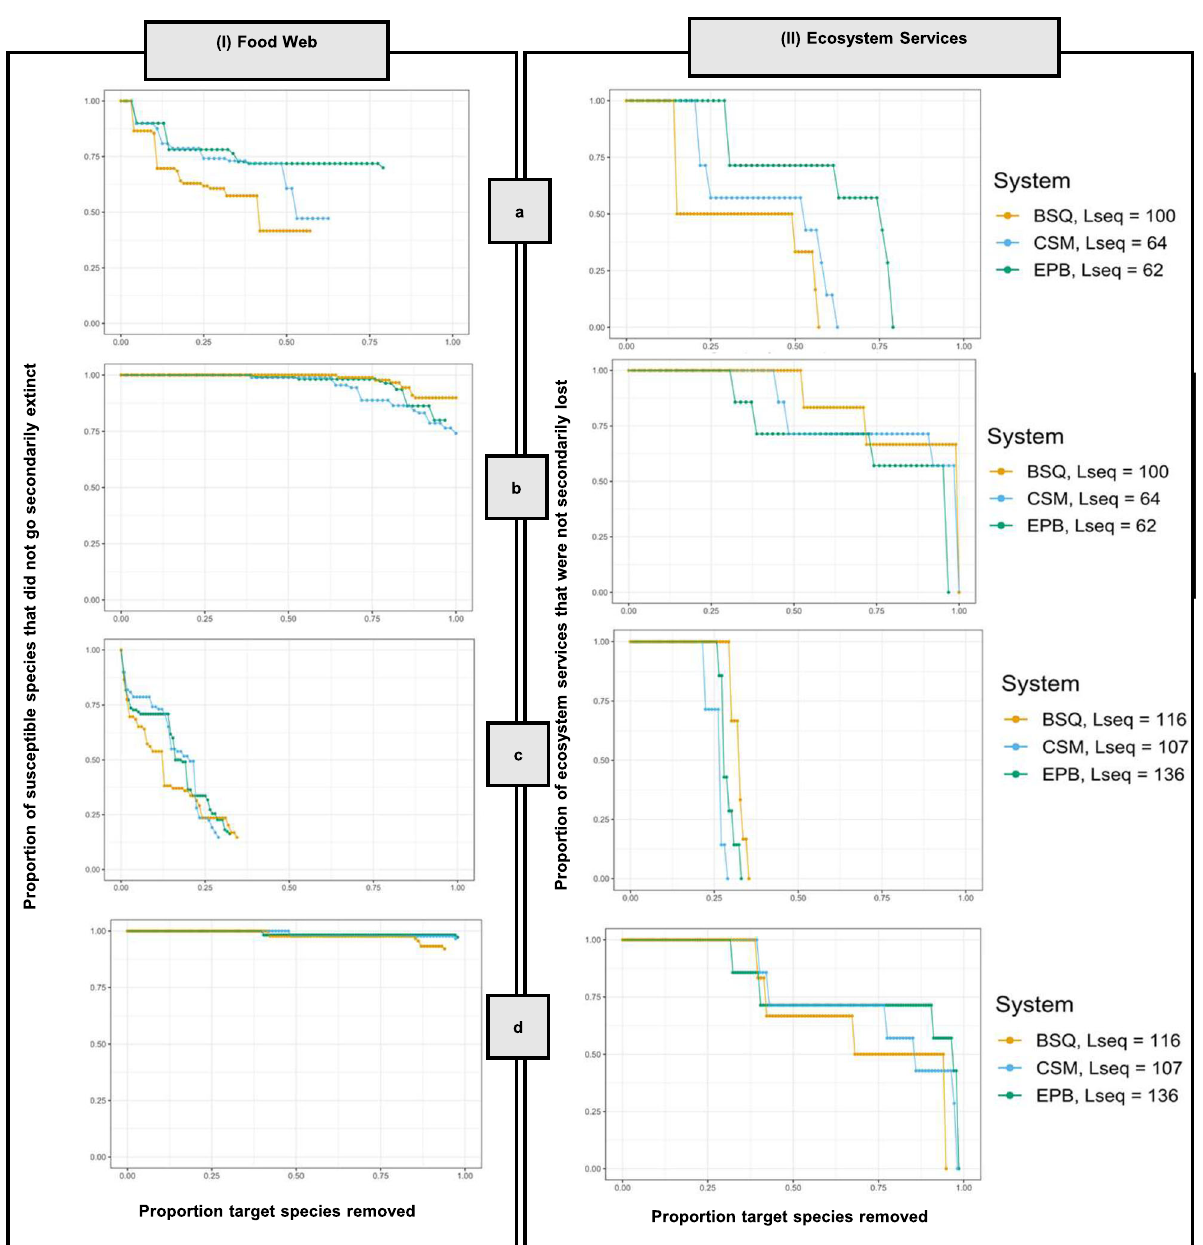
Fig. 5 Food web (I) and ecosystem service (II) responses to primary species removal result in different rates of secondary losses. Each box shows the sequential loss of species and/or ecosystem services for 4 of the 12 species loss sequences (see Supplementary Fig. 7 for the remaining sequences): a Ecosystem service providers, high to low biomass, b ecosystem service providers, low to high biomass, c Supporting species, most to least important, and d Supporting species, least to most important. The three colors show the three salt marsh systems: Bahia Falsa de San Quintin (BSQ, gold), Carpinteria Salt Marsh (CSM, blue), and Estero de Punta Banda (EPB, green). L seq indicates the length of each sequence (the denominator in the x axis). Note that not all sequences are the same